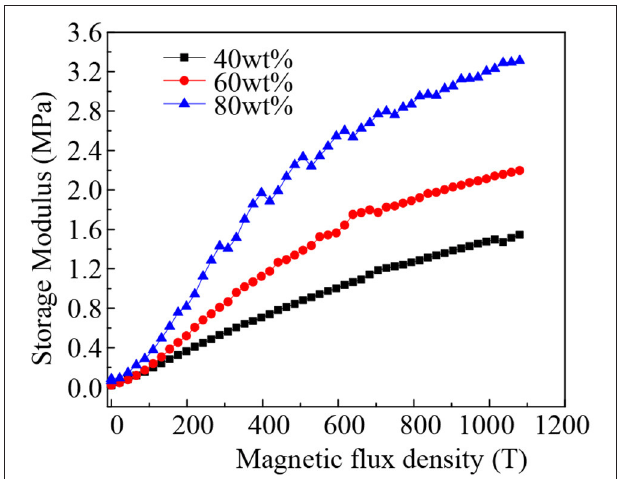
FIGURE 7 | The magnetic flux density dependence of storage modulus for the samples with different mass concentration of CIPs.